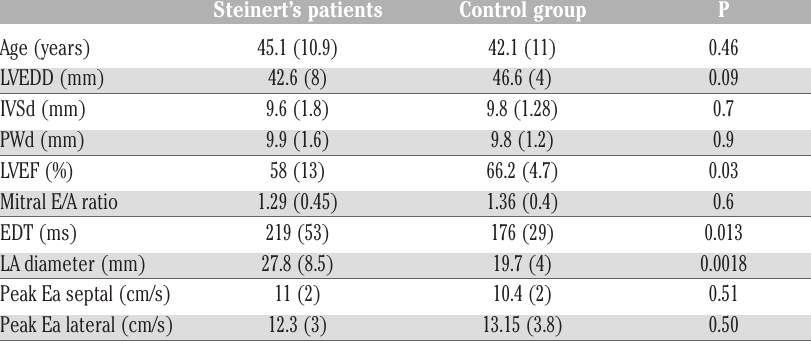
Table 1. Comparison of echocardiographic parameters between Steinert’s patients and control group. Steinert’s